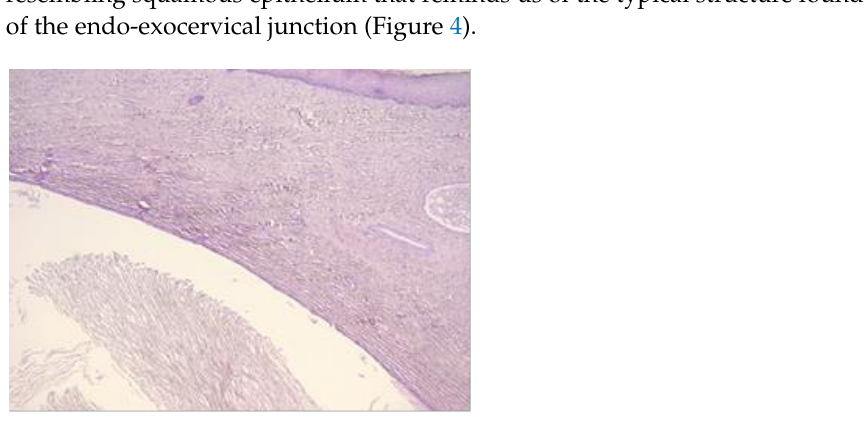
Figure 4. Cyst is lined by a stratified epithelium that resembles a squamous epithelium, similar in appearance to the endo-exocervical junctional area (HE staining, 10X). Other areas of the cyst are lined by stratified, flattened epithelium with focally outer fine, but distinct, granulated eosinophilic cytoplasm cells (Figure 5). The c yst’s epithelium, content and overlying exocervical epithelium are marked positive (Figure 6). The epithe- lium of the cyst is also marked as intensely positive (Figure 7). The myometrium presents islands of endometrial stromal and glandular structures within its thickness. In the endo- metrium, we are able to assess the ratio between the glandular structures and stroma and we notice that it is strongly modified in the gland ’ s favour. Para tubal, we see a cystic structure with amorphic, slightly eosinophilic content. This cystic formation is lined at the most intimate level by a single layer of cuboidal, cylindrical cells, sometimes presenting a flattened structure. Figure 5. Other areas of the cyst are lined by a stratified, flattened epithelium with focally outer fine, but distinct, granulated eosinophilic cytoplasm cells (HE staining, 40X).